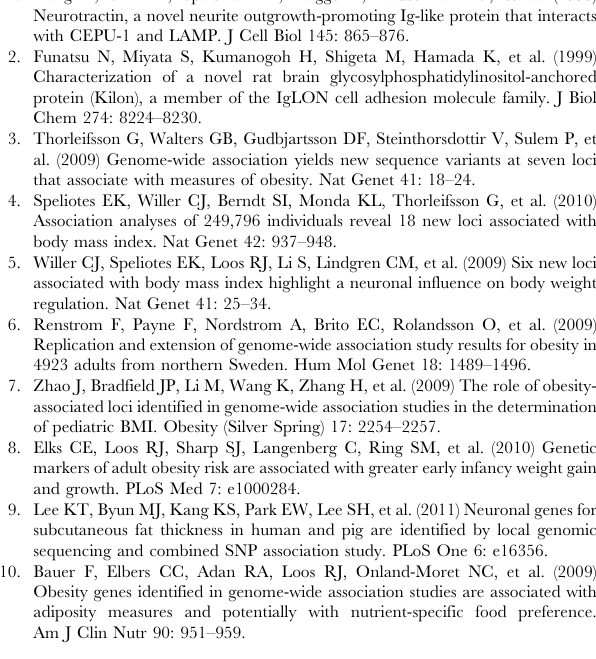
Table S1 Time-by-time ANOVA results describing phe- notypic dependence on sex and genotype. Table S2 Details of a fitted linear model, in which body mass was the response variable, and food intake and genotype were the explanatory